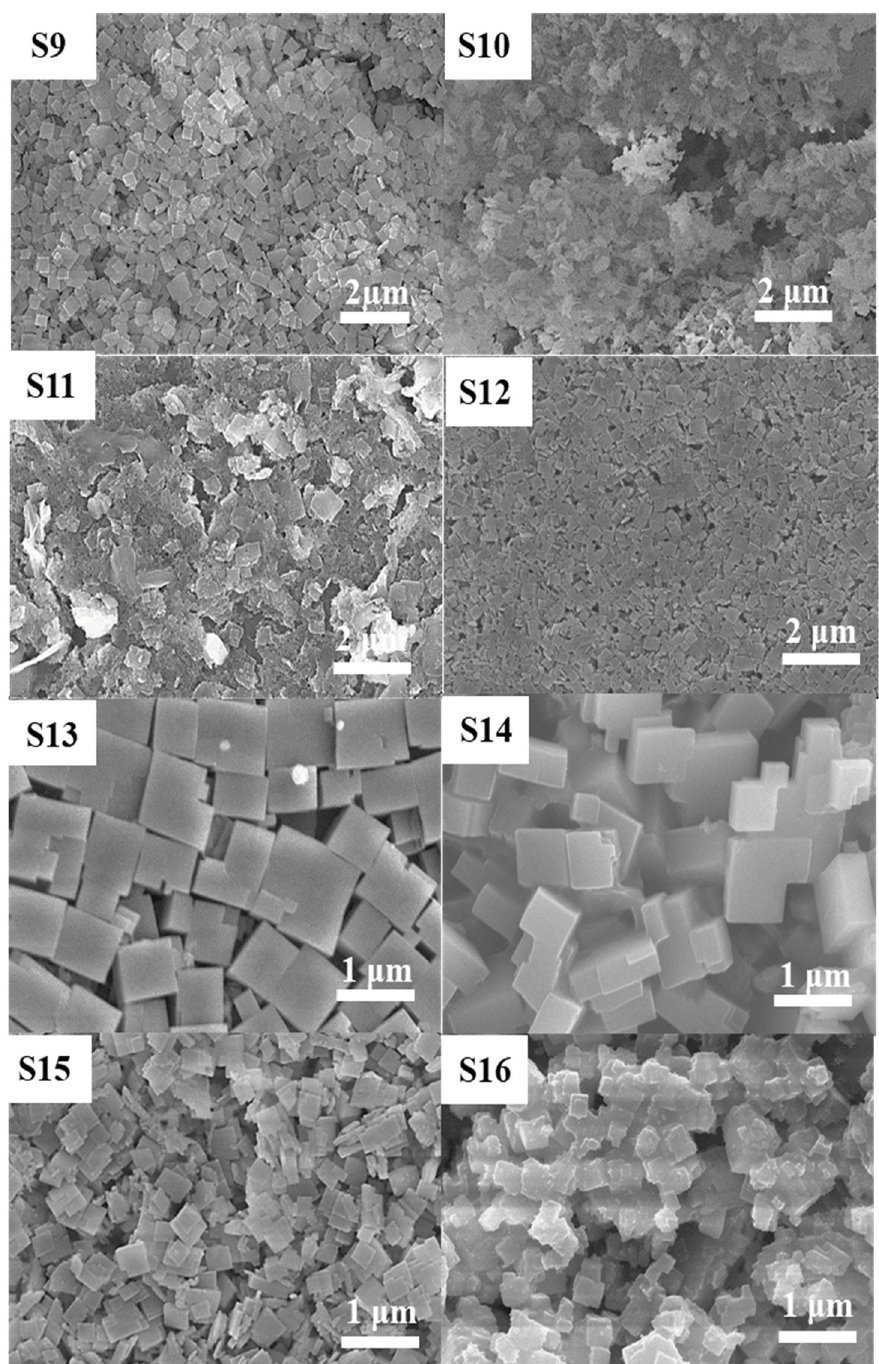
Figure 5. SEM images as-synthesized SAPO-34 particles ( S9 – S16 ) with varied P 2 O 5 concentration ( y ), synthesis time, and variation in phosphoric acid addition time. ( y ), synthesis time, and variation in phosphoric acid addition